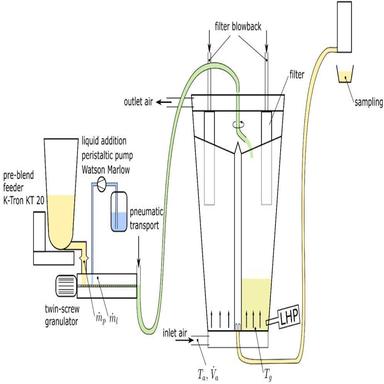
Process setup.